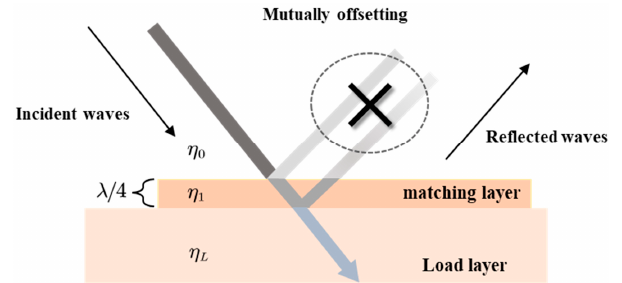
Figure 4. Quarter-wavelength impedance-matching principle.